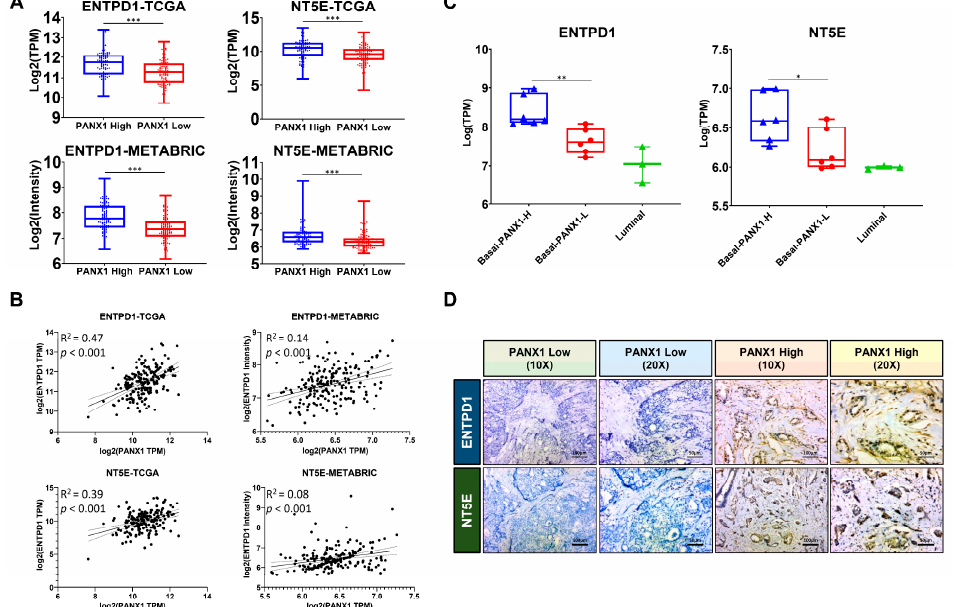
Figure 2. ( A ) ENTPD1 and NT5E expression in basal-like breast cancer under high and low level of